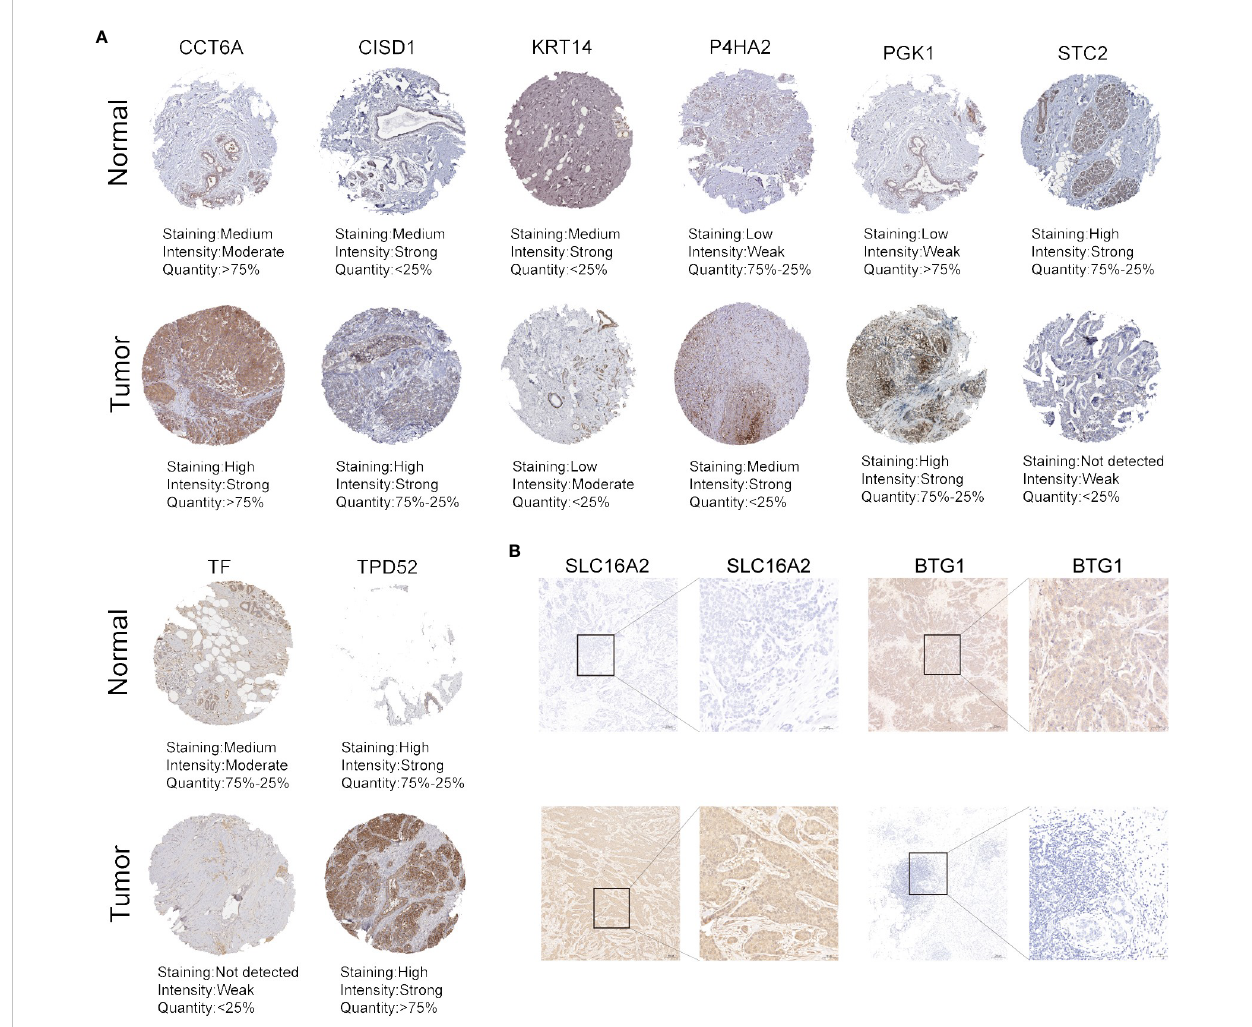
FIGURE 9 The protein expression of HFRS genes in normal and tumor samples. (A) Representative immunohistochemistry images of CCT6A, CISD, KRT14, P4HA2, PGK1, STC2, TF, and TPD52 expression between BC tissues and adjacent normal tissues. (B) IHC staining shows the protein expression of SLC16A2 and BTG1 in BC tissues and adjacent normal tissues. Scale bar: 100 m